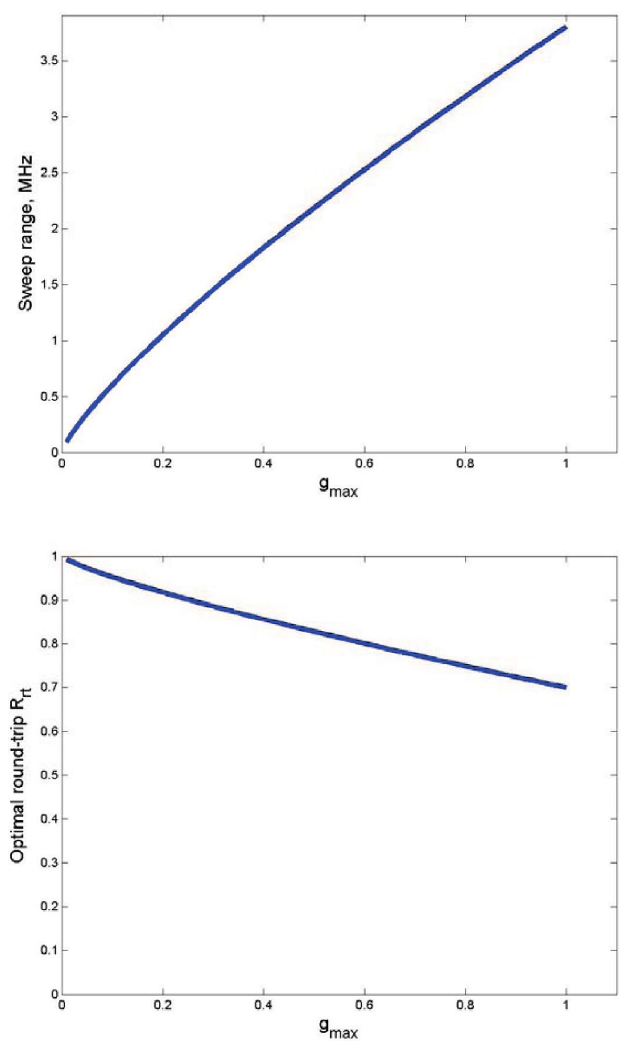
FIG. 10. (Color) The scaling of (cid:1) f and optimal round-trip sweep as functions of the maximum gain g of the reflectivity R rt max (cid:6) =P – P , assuming operating in the low gain FEL g (cid:2) (cid:5) P out in in regime ( g < 1 ). The free spectral range used was the experi- (cid:2) 115 MHz . Note that the experimen- mental measured (cid:1) f FSR tally measured chirp range (cid:1) 3 MHz [see Fig. 2(d)] falls within the estimated sweep